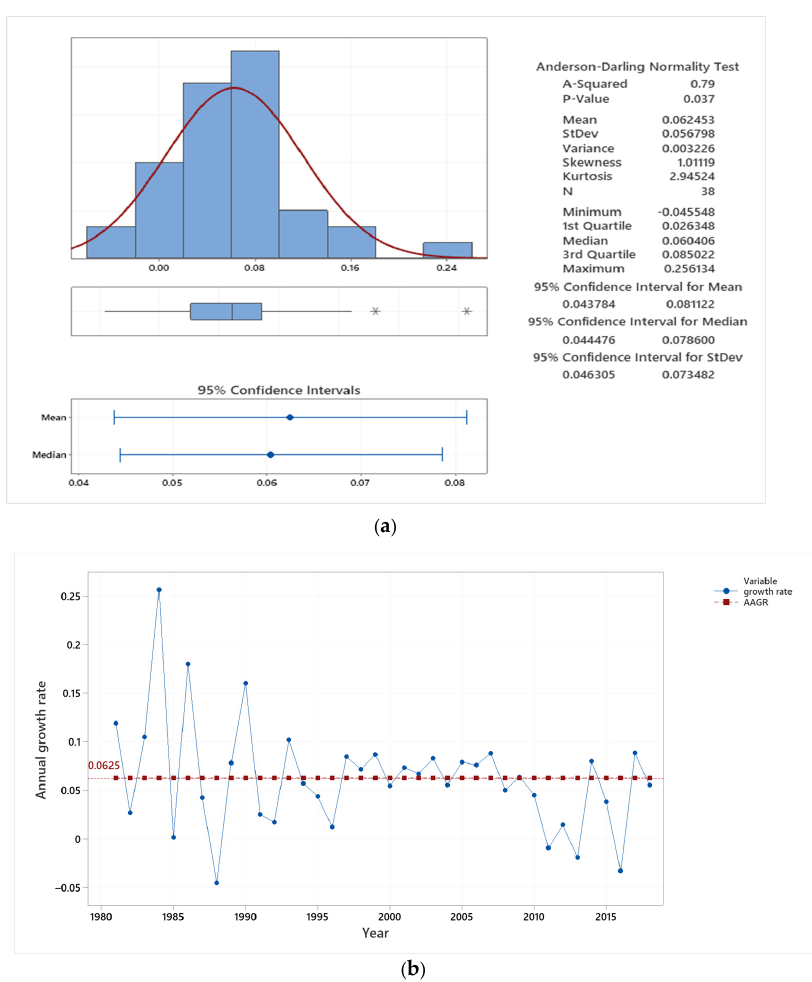
Figure 2. Analysis of annual growth rate for electricity consumption. ( a ) Shows the results of Anderson-Darling normality test and summarize the statistical parameter for annual growth rate from 1980–2018. ( b ) Shows the fluctuation of annual growth rate and red dot line presents the average value that used in the simulation. Figure 3 shows the predication of the future electricity demand for the five models according to the data collected from 1980 to 2015. The average annual growth rate (AAGR) of 6.2453% is highest curve and more conservative than others. Therefore, the constant growth rate was used in MESSAGE to identify the future electricity demand.